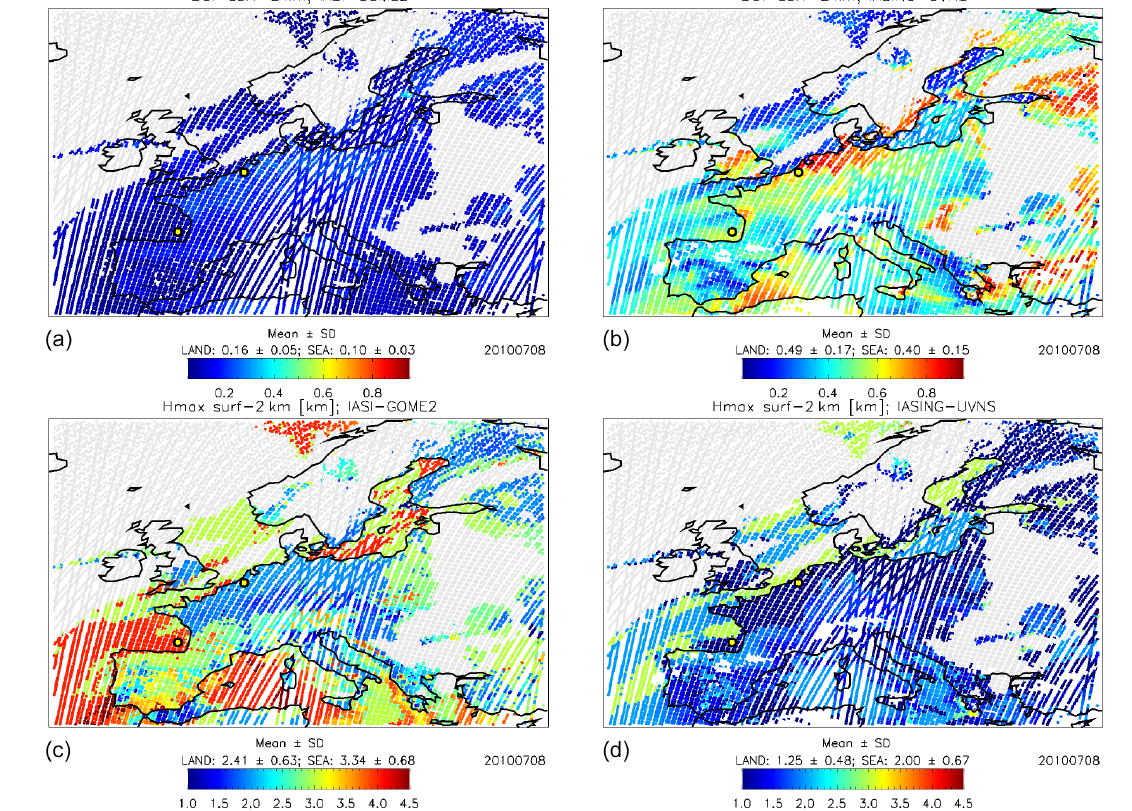
Figure 7. Maps of DOF-2km (a, b) and Hmax-2km [DU] (c, d) from IASI + GOME-2 (a, c) and IASI-NG + UVNS (b, d) pseudo- observations, for 8 July